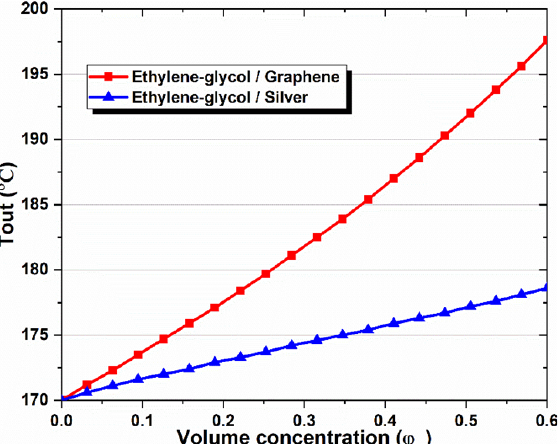
Figure 6. Effect of nanoparticle volume concentration on the outlet temperature of CPC.